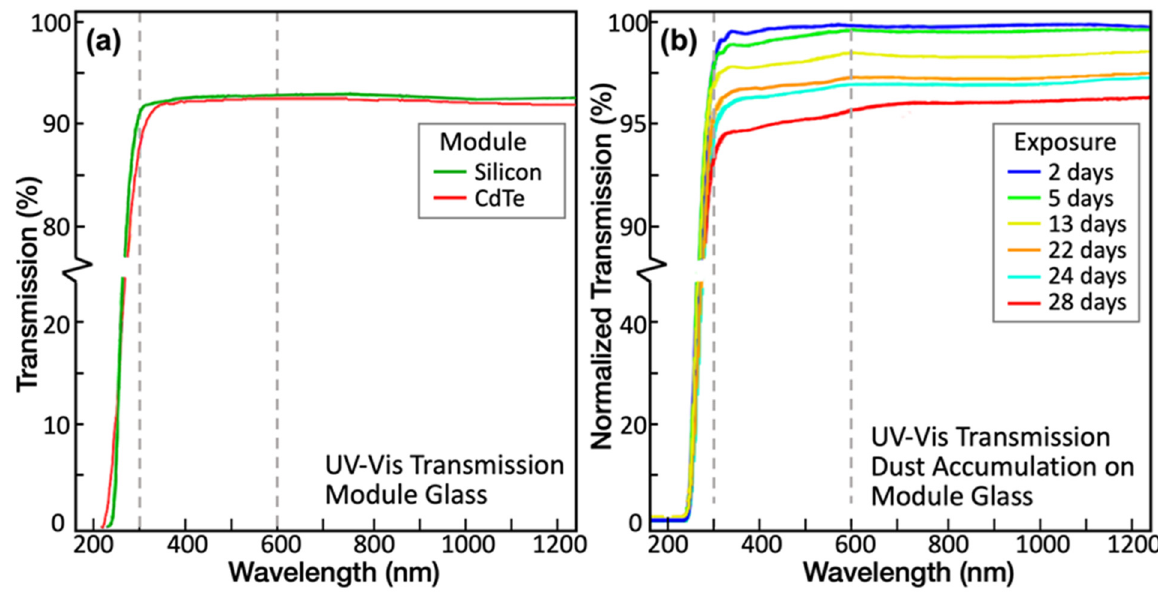
Figure 5. Transmission vs. wavelength for ( a ) module glass used in mc-Si amd CdTe modules; ( b ) spectral characteristics of accumulated soiling layer as function of exposure time indicate increased absorption by the soiling layer in the low-wavelength (300 nm to 600 nm) region that affects the higher-bandgap more than the lower-bandgap absorbers.